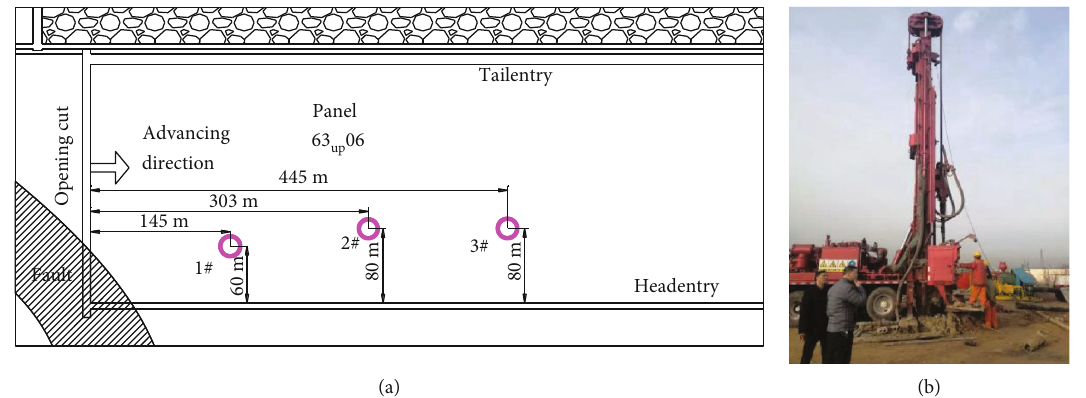
Figure 18: (a) Schematic diagram of the fracturing layout. (b) Fracturing